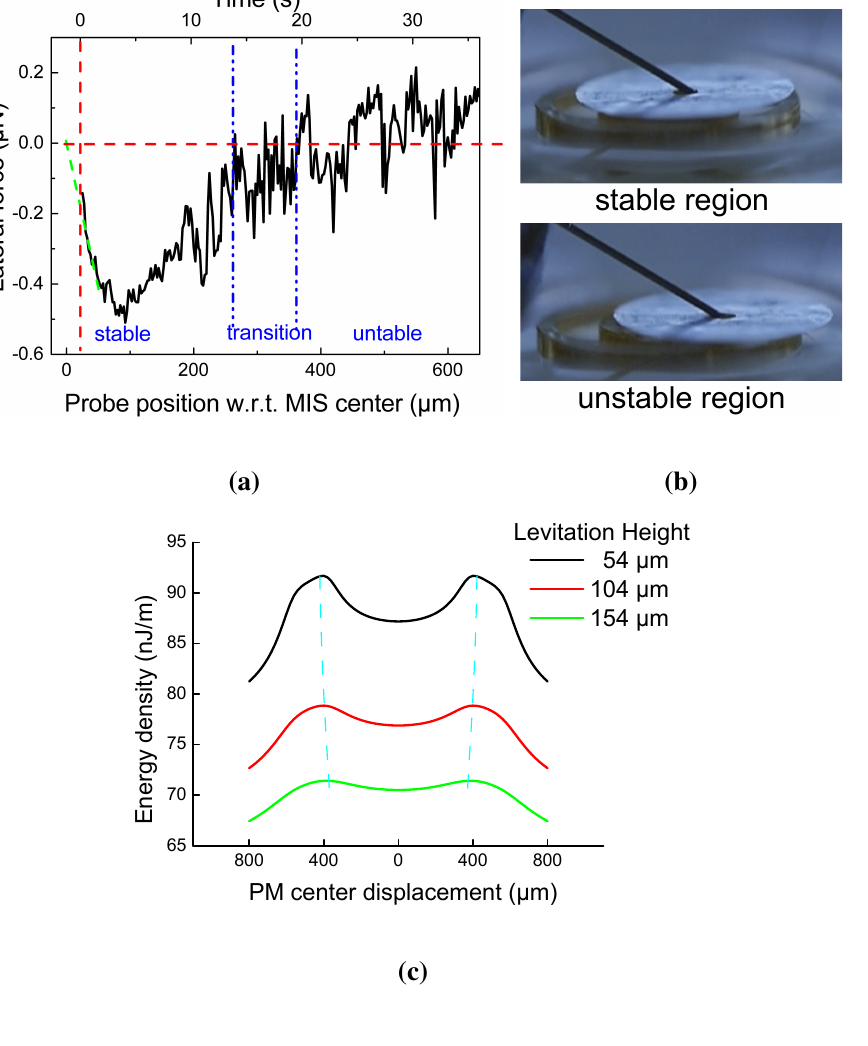
Figure 9. ( a ) Measurement of force vs. displacement. The region between the vertical blue lines represents the transition between the two states depicted in ( b ); ( b ) captures of the lateral displacement measurement corresponding to a stable (top) and unstable (bottom) position, respectively; ( c ) The system energy wells obtained by 2D simulation with variable PM center